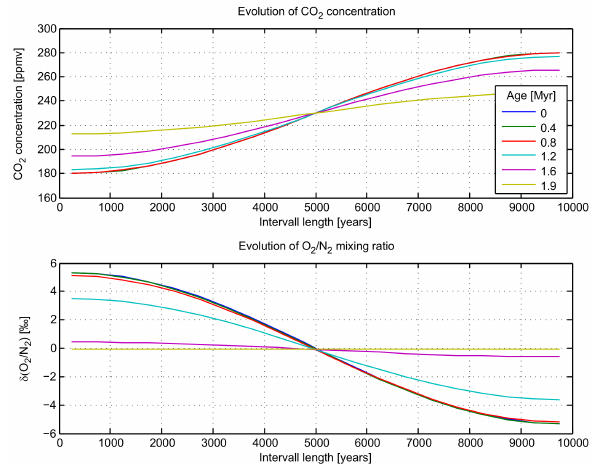
Fig. 6. Example of the model performance showing the simulated changes of the CO 2 concentration (top) and the O 2 /N 2 ratio (bot- tom) for the oldest ice core ice flow and temperature profile (Fig. 1) using the SS parameters. The starting gas distribution (dark blue line) is half of a sinusoidal oscillation (period 20kyr) with an am- plitude of 50ppmv (CO 2 ) and 5‰ (O 2 /N 2 ) over the complete sim- ulated time window of 10kyr. The different coloured lines represent simulated distributions after a certain duration in the ice as indicated by the legend (in million years [Myr]). This simulation is used to calculate the amplitude dampening of the 20kyr signal (see Fig.